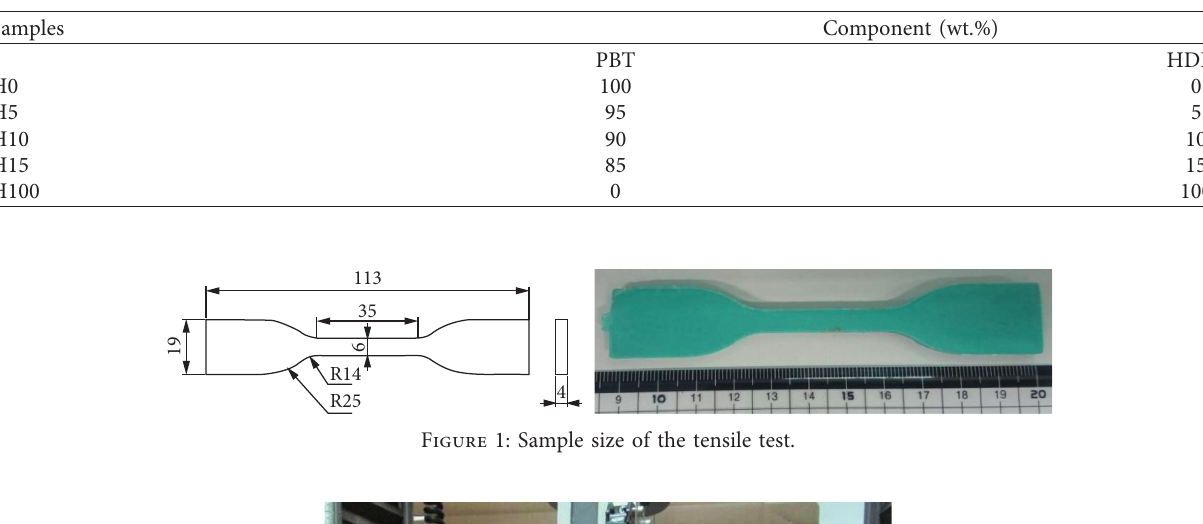
Table 1: Composition of the testing sample.